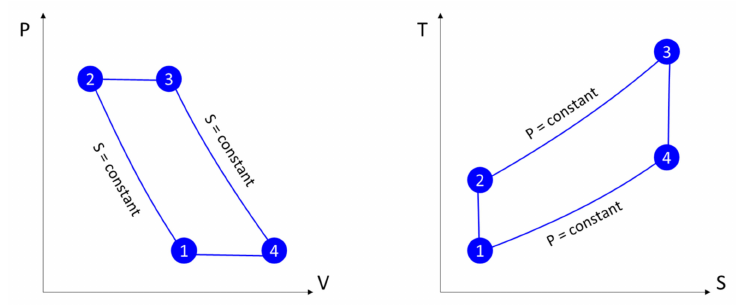
Figure 2. P-v and T-s diagrams of an ideal Brayton